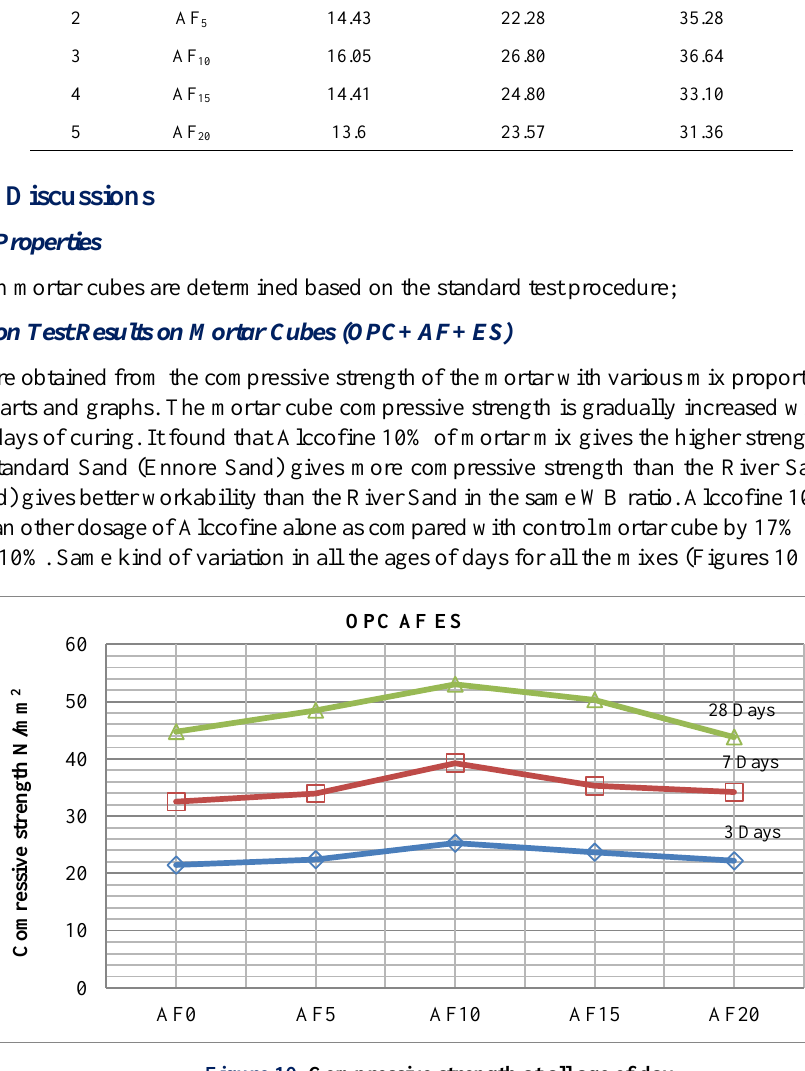
Figure 10. Compressive strength at all age of